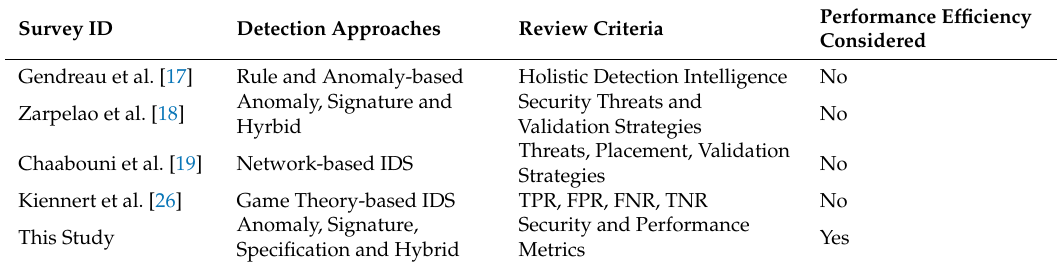
Table 1. Comparison of this study with existing reviews of intrusion detection systems (IDSs) for Internet of Things